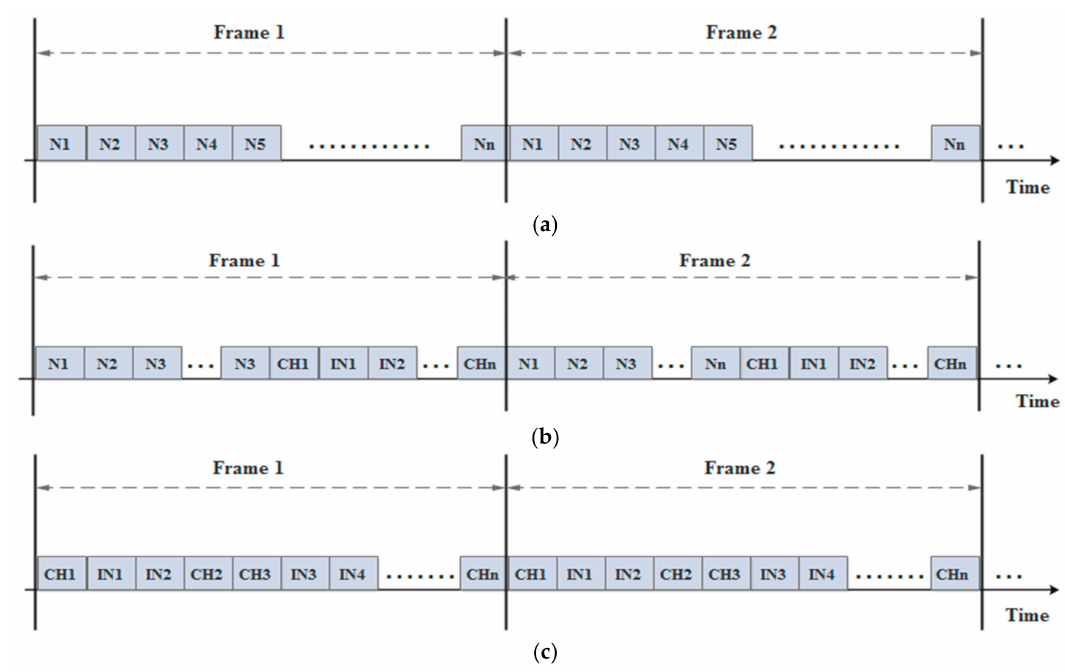
Figure 6. The Time- Division Multiple Access (TDMA) schedule of ( a ) N; ( b ) CH; and ( c ) IN.